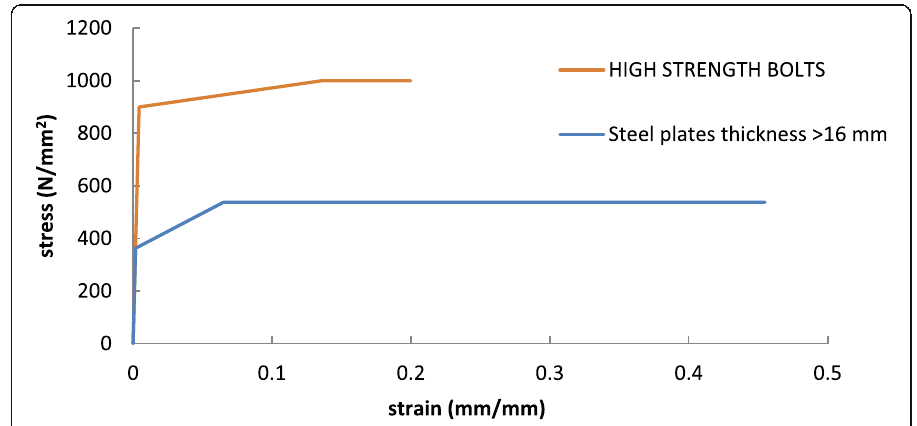
Fig. 4 Trilinear stress-strain curve for steel plates with thickness more than 16 mm and high strength bolts